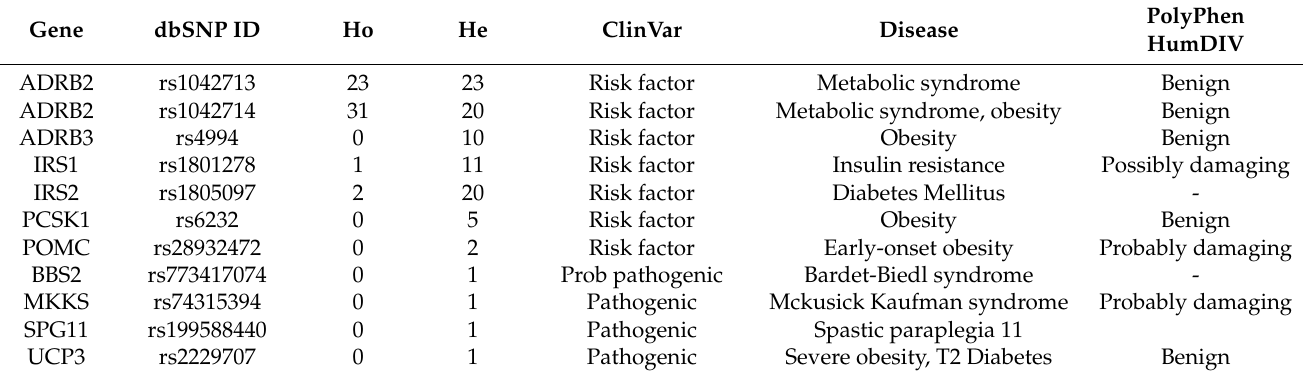
Table 4. Clinical association of the identified variants potentially associated with obesity.